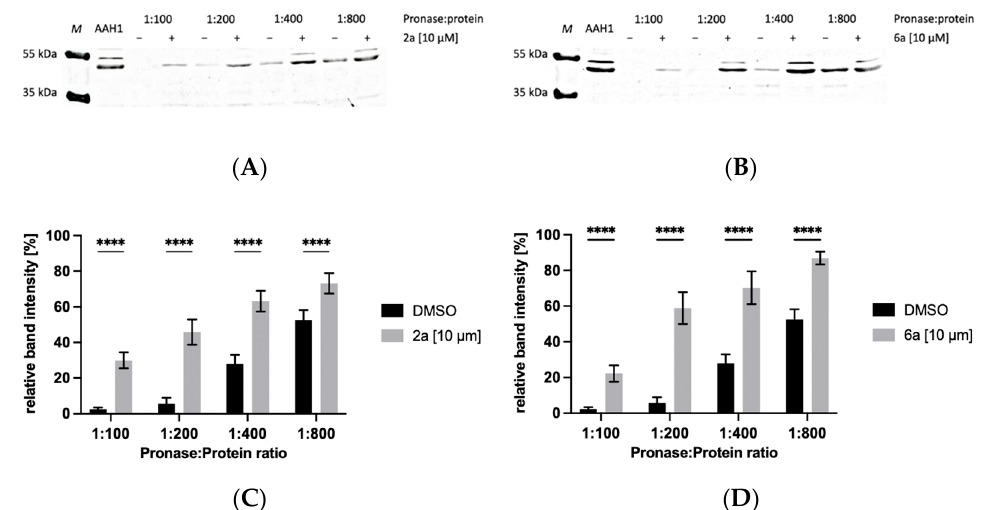
Figure 4. Protection of AAH1 from proteolysis by 4-arylthiosemicarbazide derivatives in the presence of 10 µ M compound and with the Pronase:protein ratio. Western blots of AAH1 from the drug affinity responsive target stability assay and relative band intensity analysis. ( A ) Protection of AAH1 from proteolysis by 2a in the presence of 10 µ M compound. ( B ) Protection of AAH1 from proteolysis by 6a in the presence of 10 µ M compound. ( C ) Proteolytic activity inhibition by 2a protecting AAH1. ( D ) Proteolytic activity inhibition by 6a protecting AAH1. The intensities of the AAH1 bands were quantified using ImageJ software. Values with statistically significant differences are labeled by asterisks; **** p < 0.0001. Data were compared using one-way ANOVA with Tukey’s multiple comparisons test. Data were obtained from three independent experiments and are expressed as means ± standard deviations.